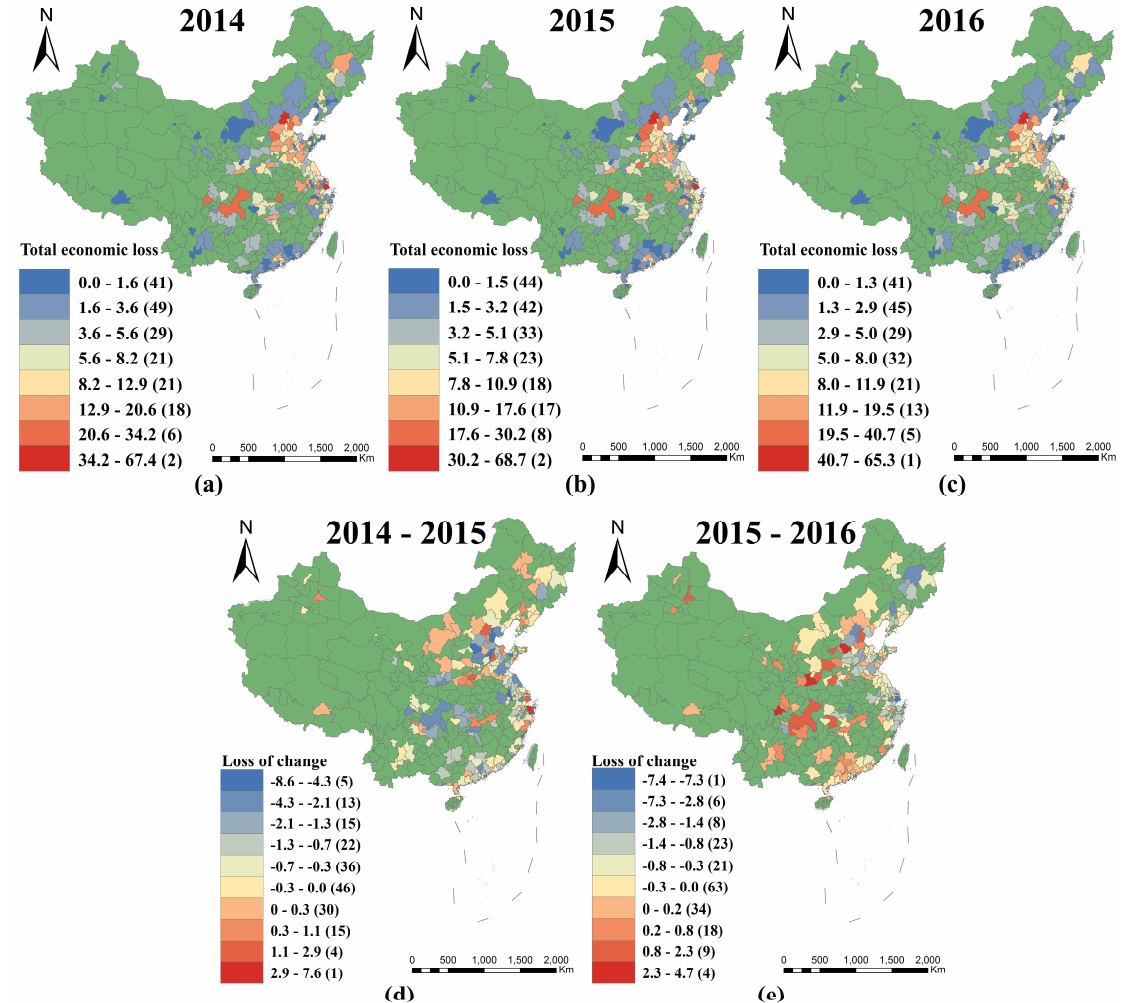
Figure 7. Spatial distribution of PM 2.5 -related economic losses in the upper bounds in 2014 ( a ); 2015 ( b ); and 2016 ( c ). Distribution of changes in PM 2.5 -related economic losses in the upper bounds for the periods 2014–2015 ( d ) and 2015–2016 ( e ).